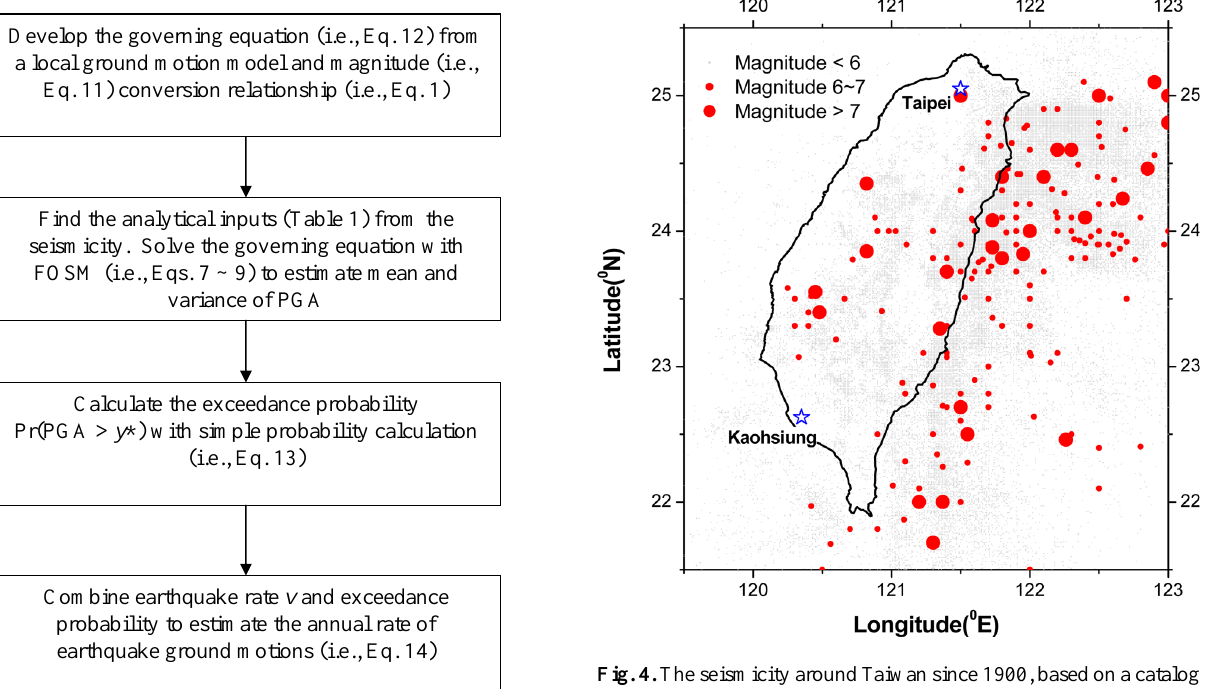
Fig. 3. A chart summarizing the FOSM application of this study to earthquake hazard assessment